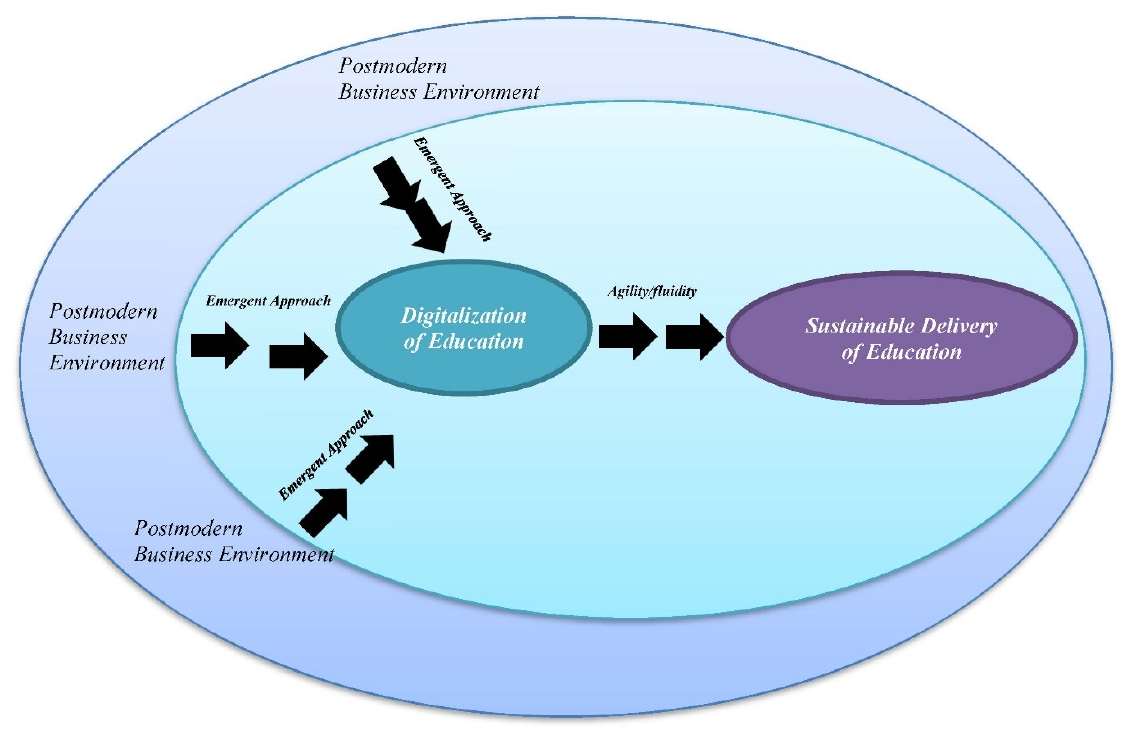
Figure 9. An emergent education strategy approach amid postmodernisms. Source: Based on Fixson and Rao (2014), Toit and Verhoef (2018) and Authors proposal (2022).